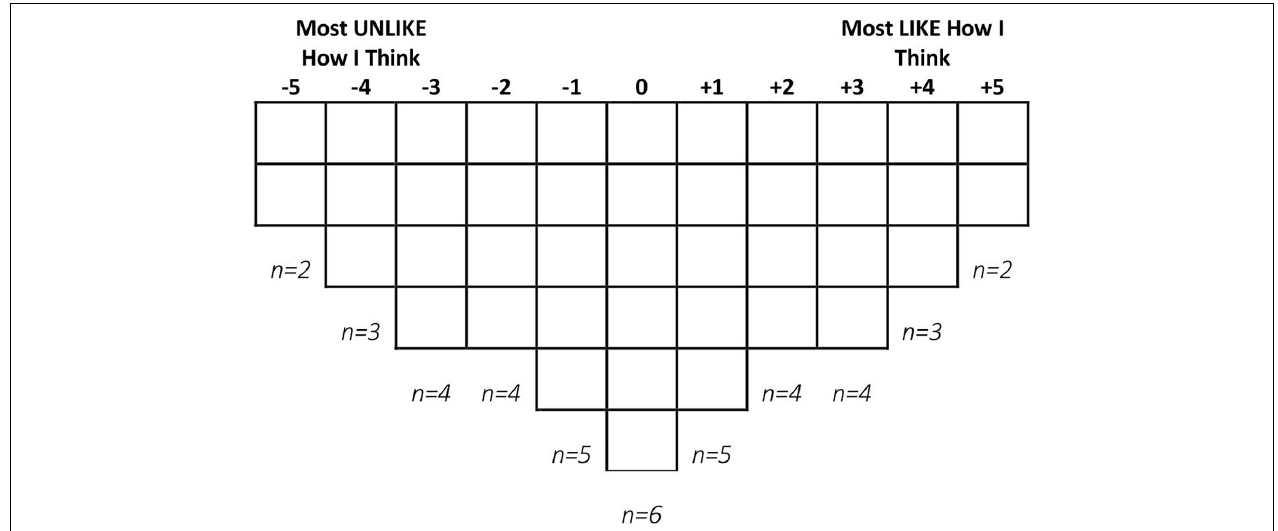
FIGURE 3 | Quasi-normal distribution grid utilised in Q-study: Participants ‘sort’ statements ( n ) by placing them into a column of a pre-defined, quasi-normal distributed grid based on their personal perceptions.